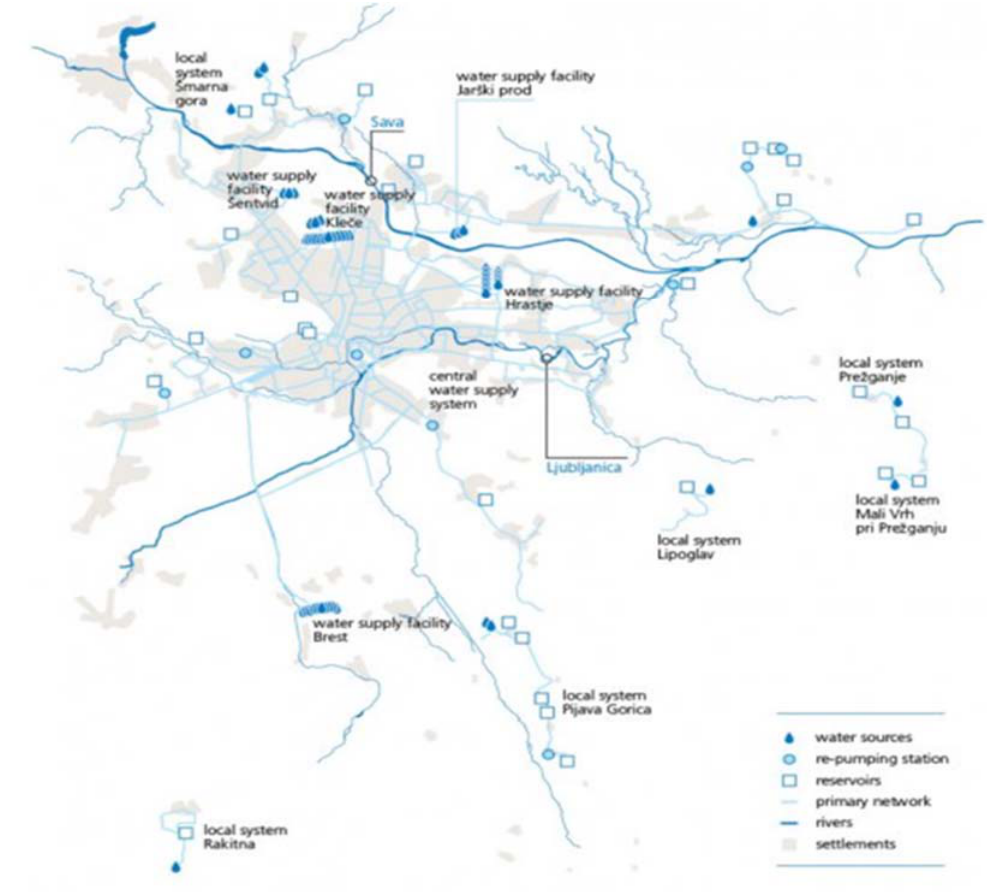
Figure 1. Drinking water supply system operated by VO ‐